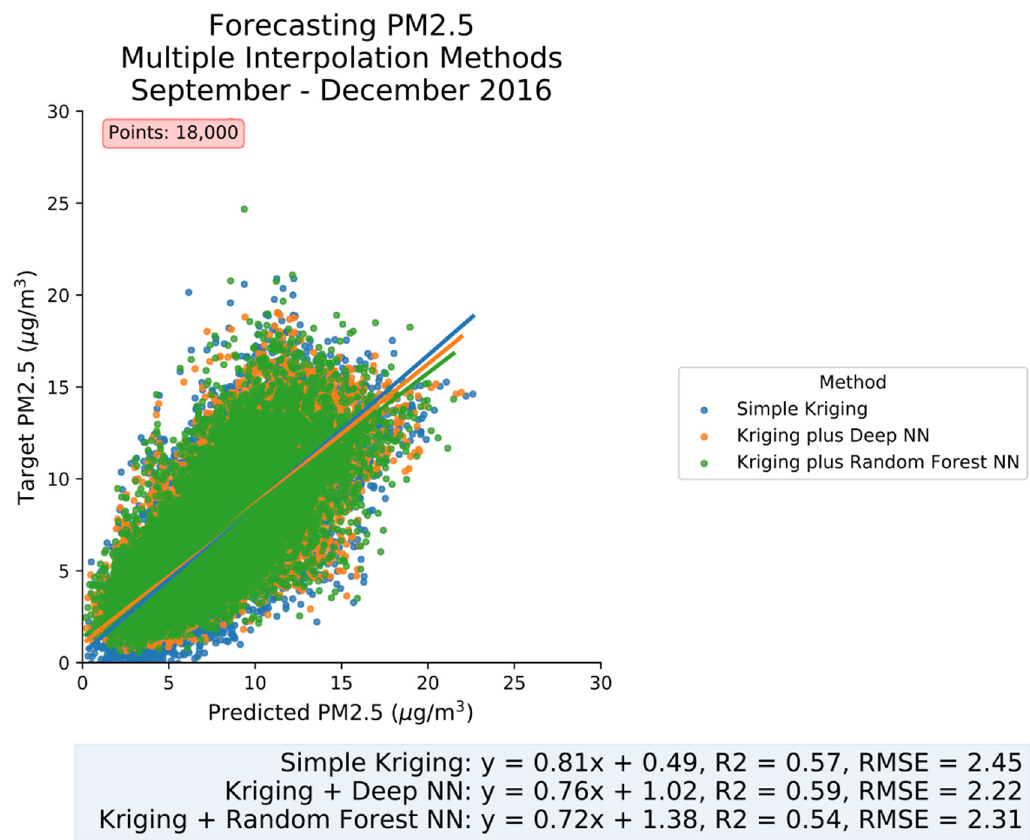
Figure 5. All spatial methods tested as inputs in the fine particulate matter (PM 2.5 ) neural network forecaster.